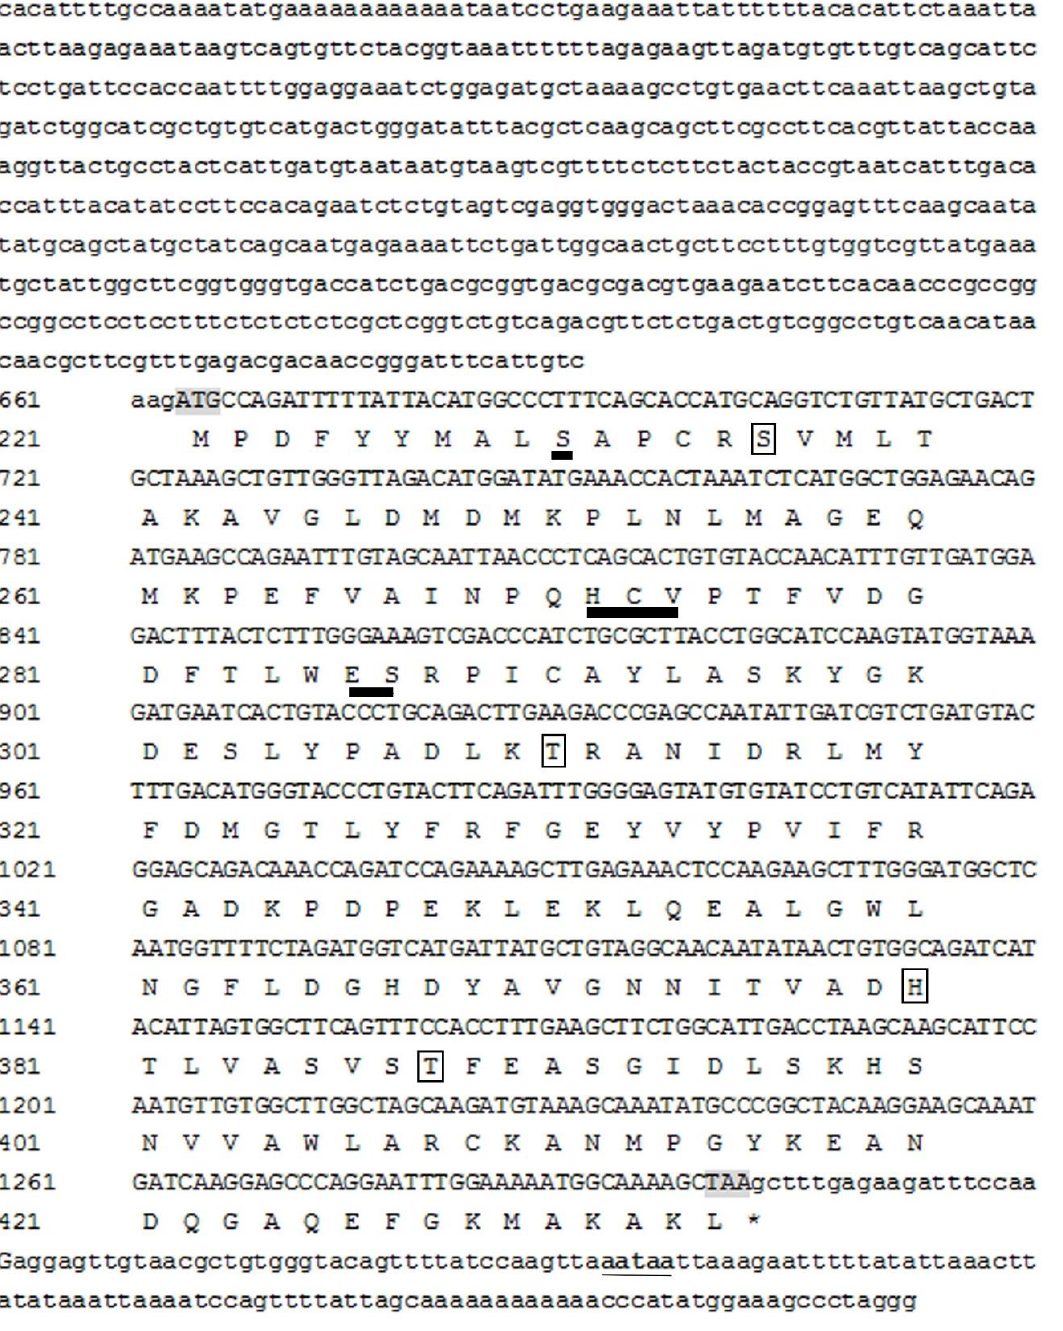
Figure A1. Nucleotide and predicted amino acid sequences of MnGST-1 from oriental river prawn, Macrobrachium nipponense . Amino acid sequences are shown as capital letters below the nucleotide sequences. Black rectangles indicate the four potential O-GlcNAc sites. Black underlines indicate highly-conserved residues. The start codon (ATG) is boxed. The Stop codon (TAA) is shaded in grey. The protein translation terminator was denoted with an asterisk. The AATAA sequence is a potential polyadenylation signal, represented by an underscore.